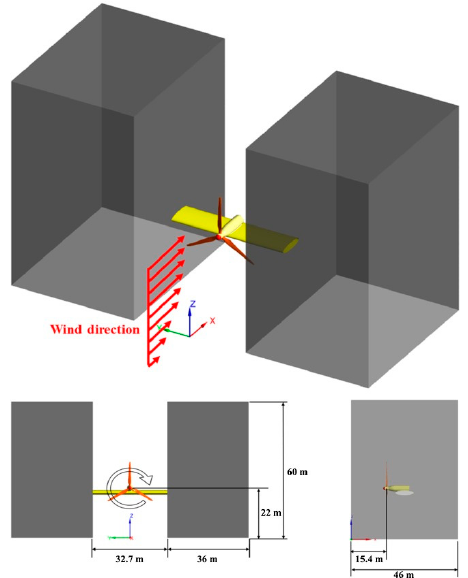
Figure 13. Configuration of the 110-kW wind turbine and buildings with a sky bridge studied in [63].